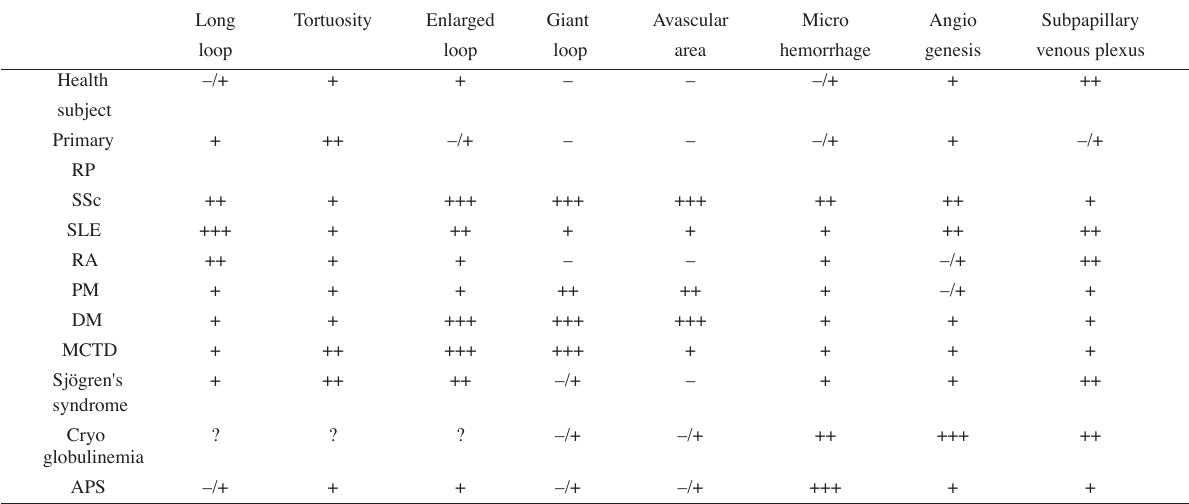
RP, Raynaud's phenomenon; SSc, systemic sclerosis; SLE, systemic lupus erythematosus; RA, rheumatic arthritis; PM, polymyositis; DM, dermatomyositis; MCTD, mixed connective tissue disease; APS, antiphospholipid